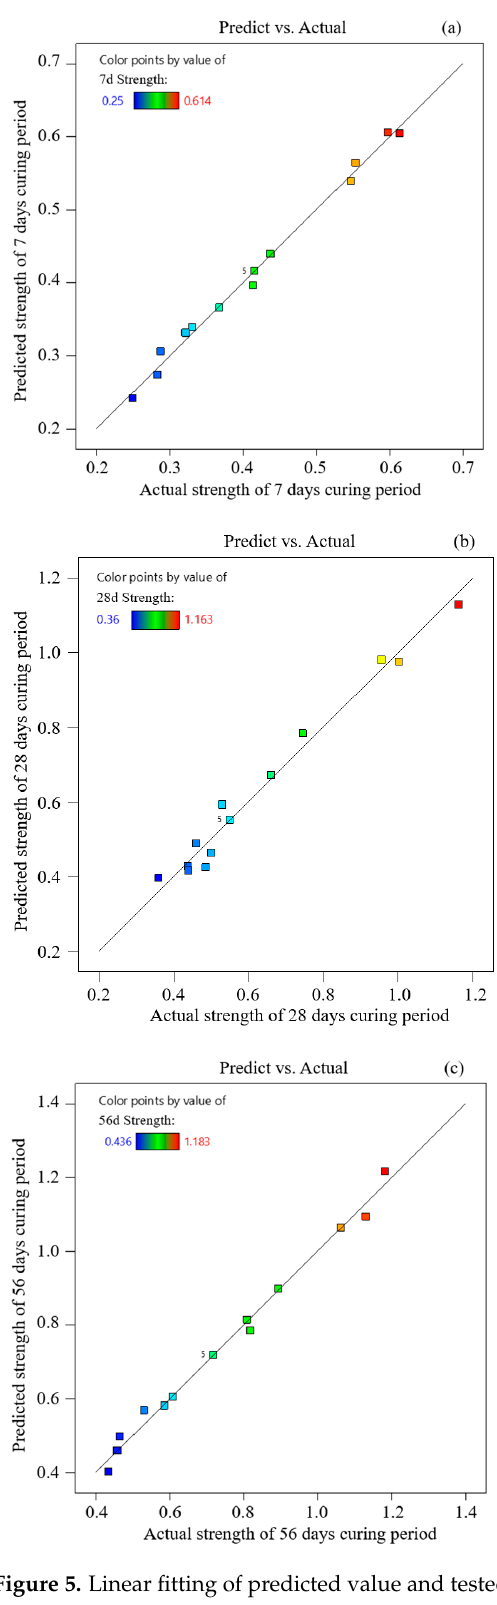
Figure 5. Linear fitting of predicted value and tested value ( a ) curing age at 7 days; ( b ) curing age at 28 days; ( c ) curing age at 56